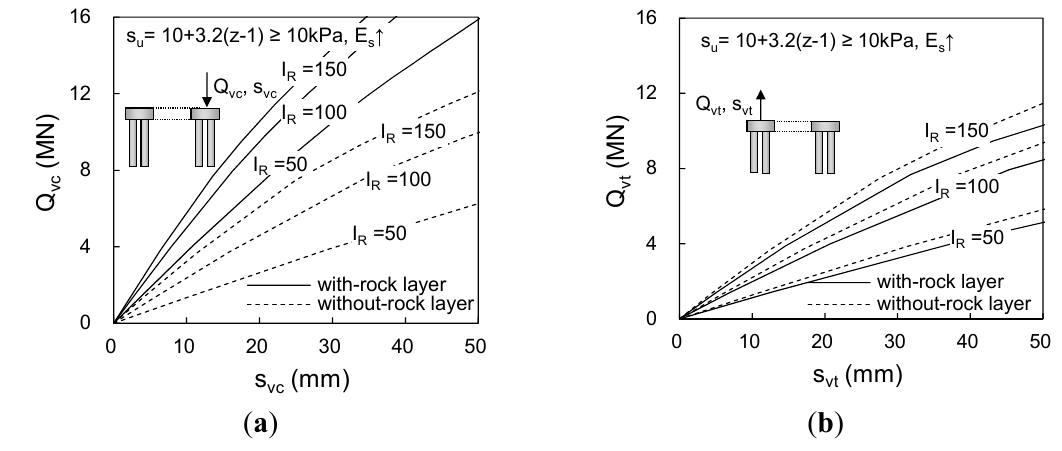
Figure 14. Load-displacement curves of connected foundations with and without bearing rock layer: ( a ) compressive and ( b ) uplift